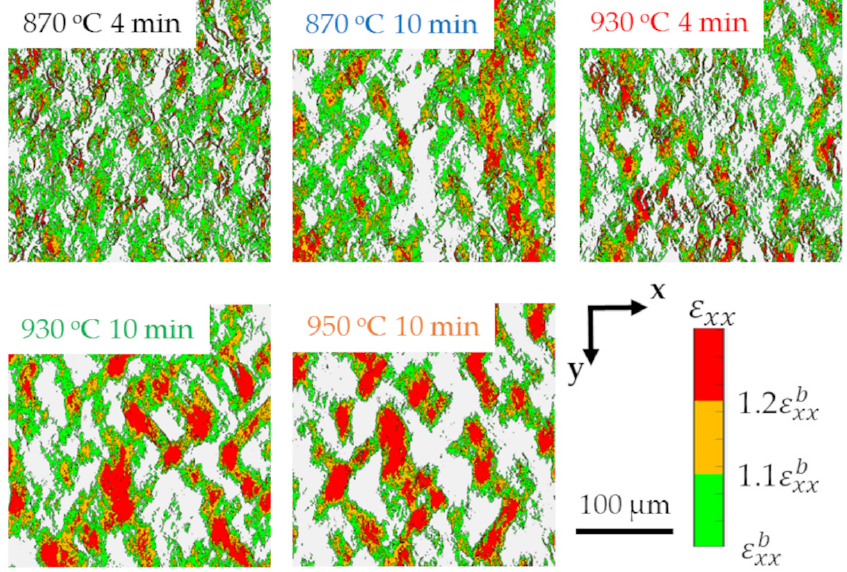
Figure 7. The distribution of axial strain, 𝜀 (cid:3051)(cid:3051) , in a 270-by-270 μ m 2 region in the center of the gauge section of the dog-bone specimens of the five heat-treated martensitic steel deformed to a macroscopic tensile strain of 0.048 ± 0.004. The loading direction is along the x-axis.